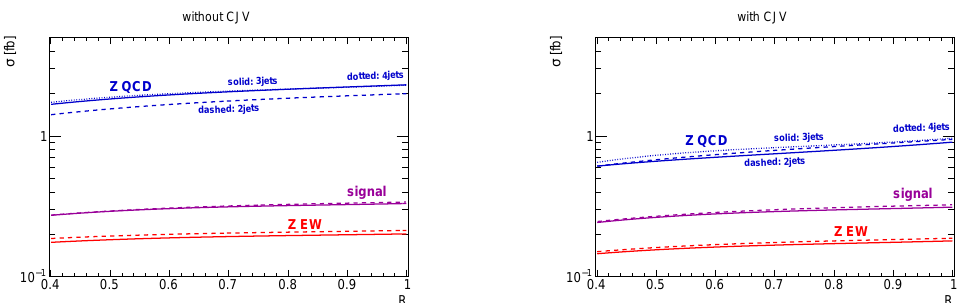
Figure 4: WBF signal and Z background cross section dependence on R without (left) and with (right) central jet veto. We always require the basic acceptance cuts of